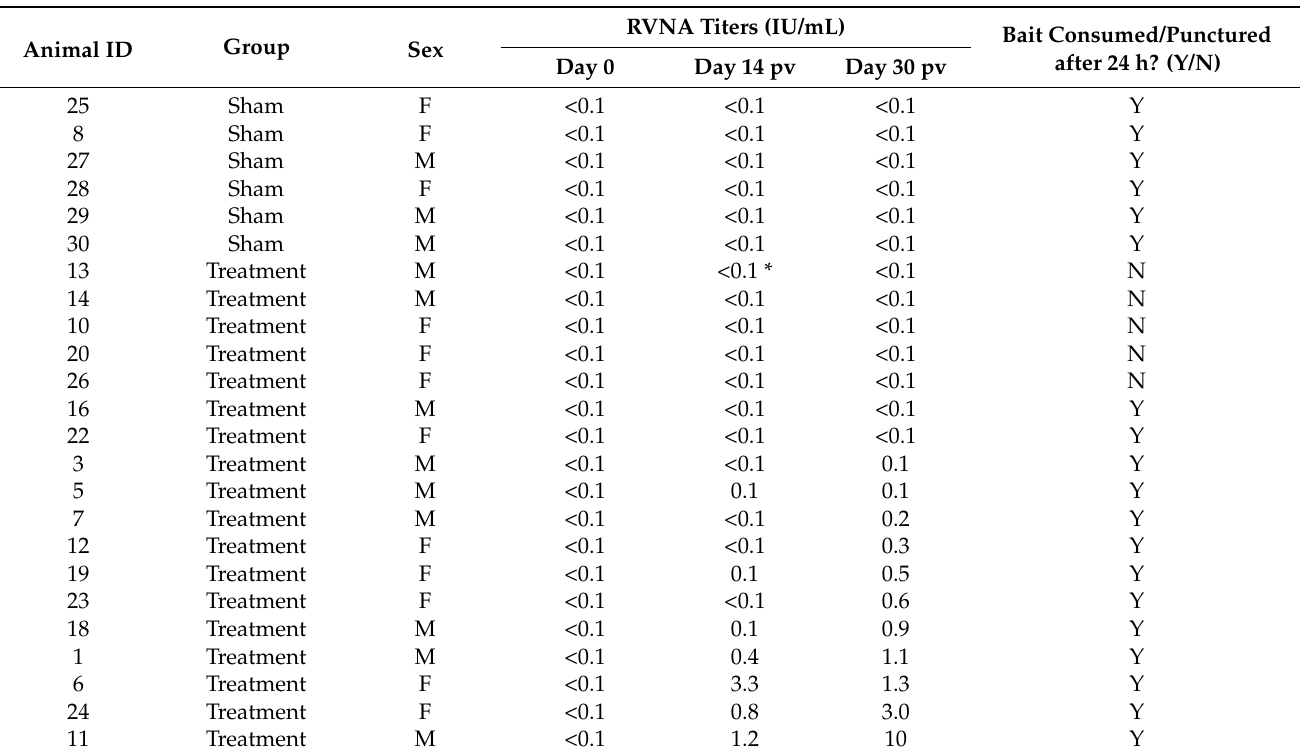
Table 2. Individual RVNA titers in 24 small Indian mongooses ( Urva auropunctata ) prior to treatment and days 14 and 30 post-offering of Ontario Rabies Vaccine Ultralite baits. * Sample collected on day